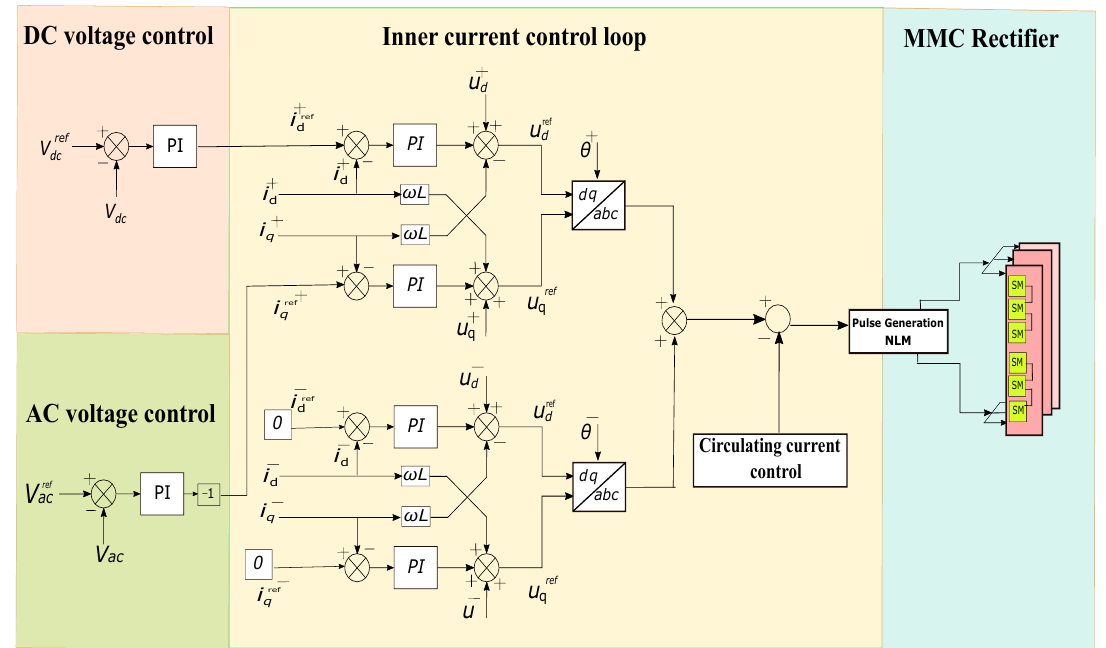
Figure 13. Outer and inner control loop for the MMC-rectifier. This is achieved by creating a d -axis reference current for the inner current loop (ICL), comparing reference DC voltage to DC voltage measured, with an error signal I d feeding + ref the PI controller. Output reference I is fed to the inner current control d